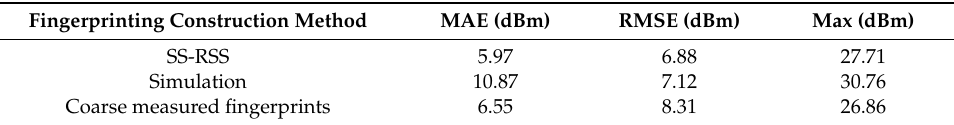
Table 2. Typical values of the RSS fingerprint construction methods.